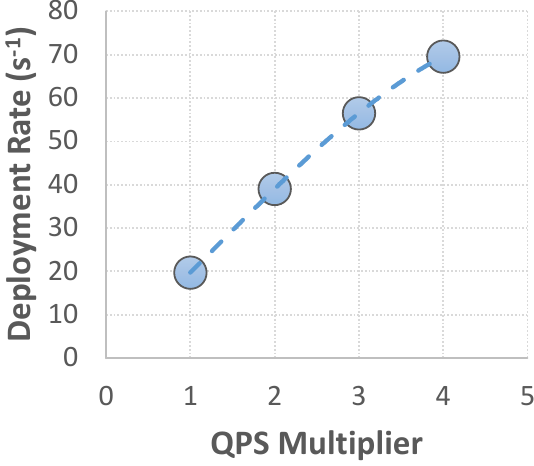
Fig. 3. Sustained rate of the pause container deployment for different values of the QPS parameter set. With QPS values four times higher than the Kubernetes default configuration, a sustained rate of 70 containers per second is